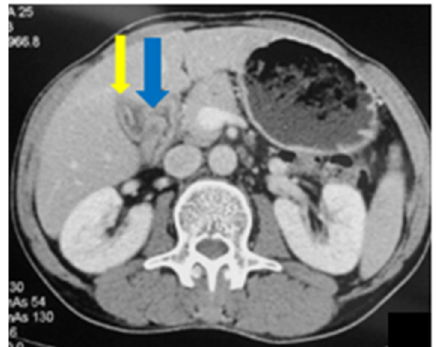
Figure 8. Abdominal CT: mild wall thickening of the gallbladder (blue arrow) with pericholecystic inflammatory changes (yellow arrow).